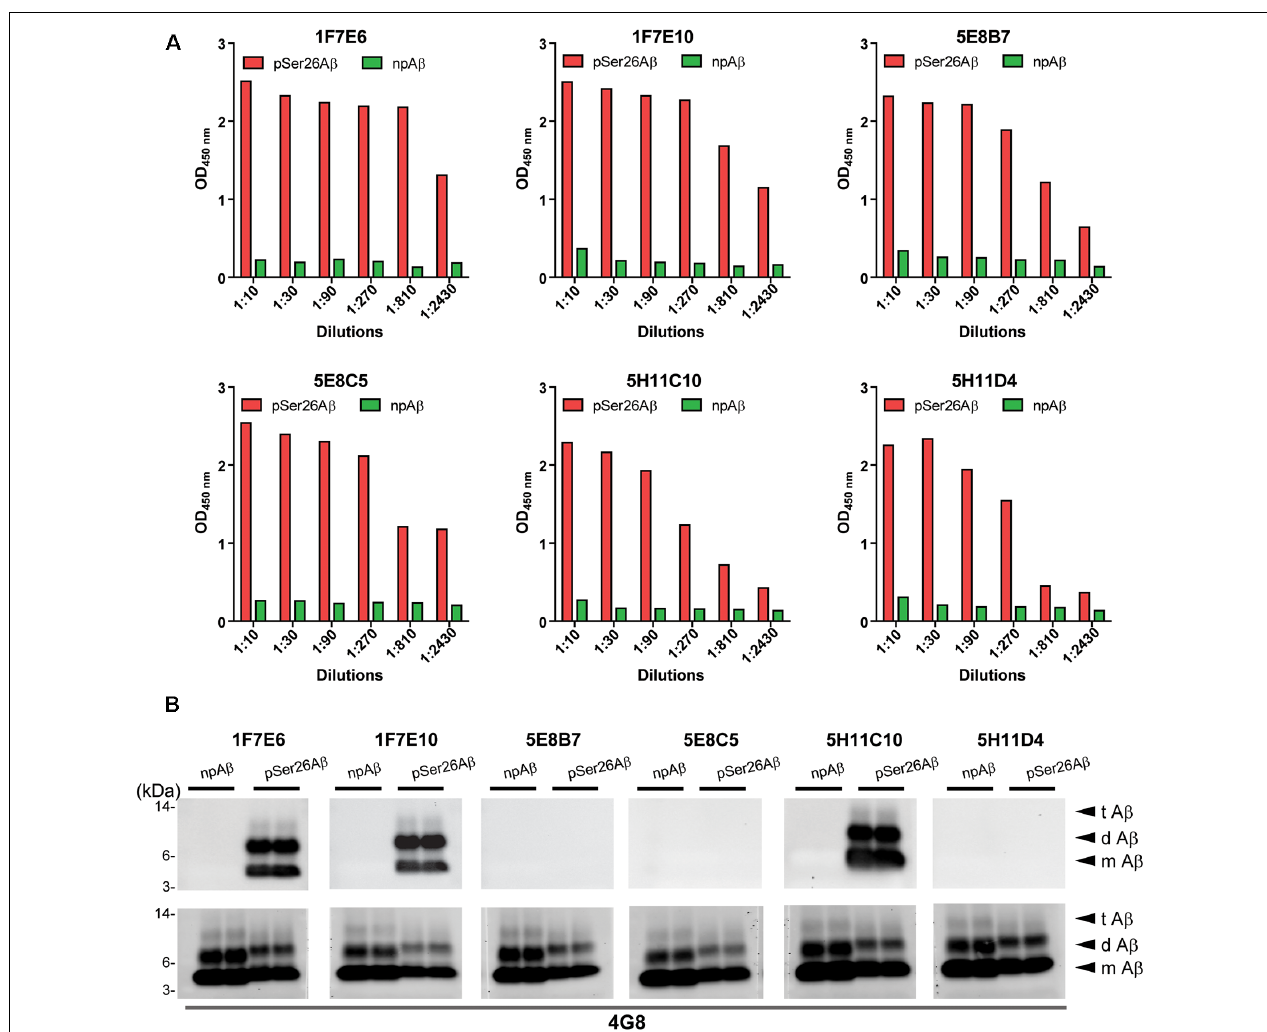
FIGURE 1 | Screening hybridomas secreting anti-pSer26A β monoclonal antibodies. (A) Enzyme-linked immunosorbent assay (ELISA) assay of hybridoma supernatants with synthetic pSer26A β and npA β peptides demonstrate specific reactivity against the pSer26A β peptides even at higher dilutions. Six hybridoma clones demonstrate a positive reaction to the pSer26A β peptide. (B) Western Blotting (WB) analysis of synthetic npA β and pSer26A β peptides (200 ng) with hybridoma supernatants shows the specific detection of monomeric (m A β ), dimeric (d A β ), and trimeric (t A β ) species of pSer26A β by three hybridoma clones. 5H11C10 demonstrates the highest reactivity. Reprobing of the blot with generic A β antibody 4G8 was used to detect both npA β and pSer26A β peptide